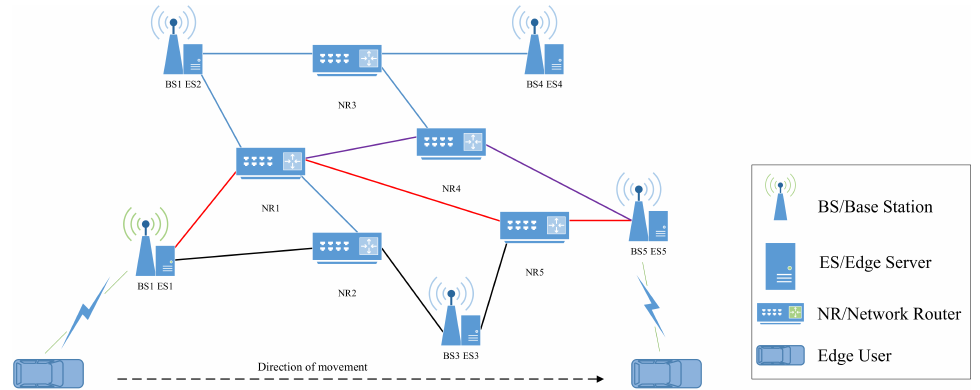
Figure 2. Abstract VEC network